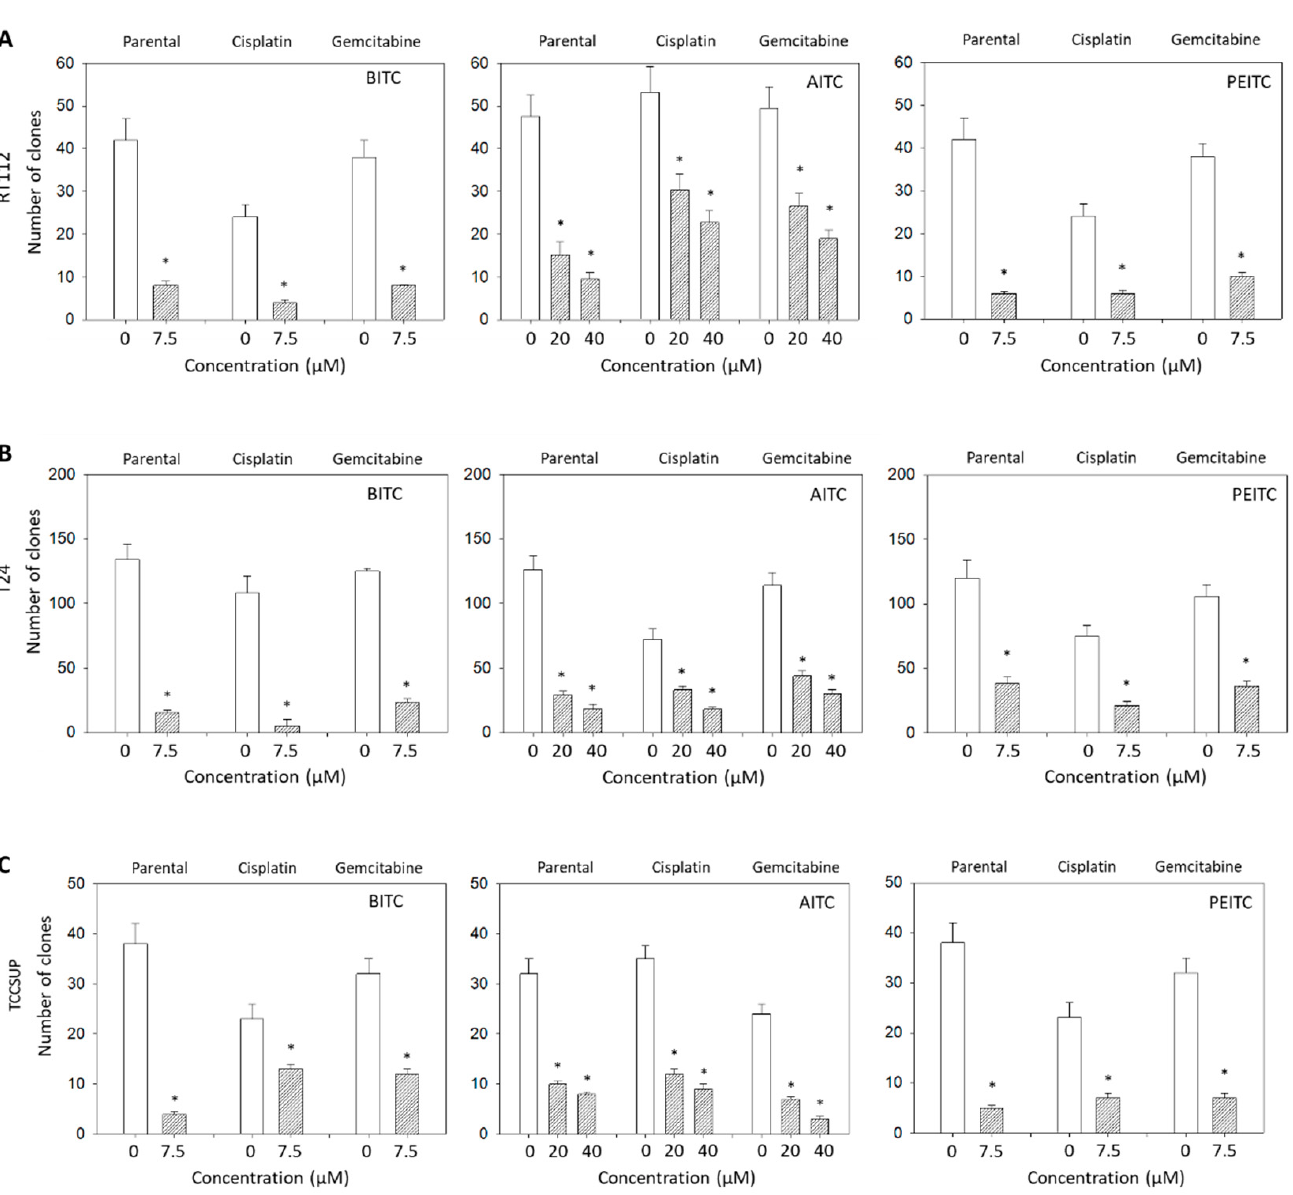
Figure 6. Number of RT112 ( A ), T24 ( B ), and TCCSUP ( C ) clones (parental, cisplatin-resistant, gemcitabine-resistant) exposed to BITC (7.5 µM), AITC (20, 40 µM) or PEITC (7.5 µM), indicated as stripped bars. Controls remained untreated (white bars), n = 3. * indicates a significant difference to untreated controls.